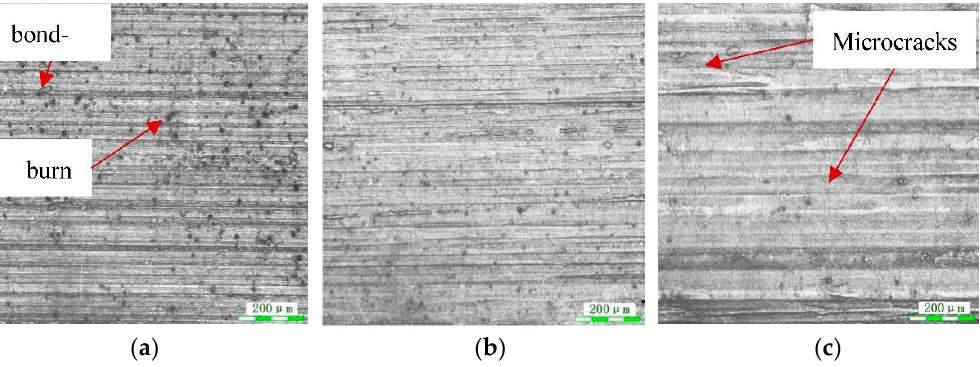
Figure 2. Two-dimensional view of the surface morphology of sample No. 5 (20x). ( a ) cutting-in area; ( b ) middle area; ( c ) cutting-out area.